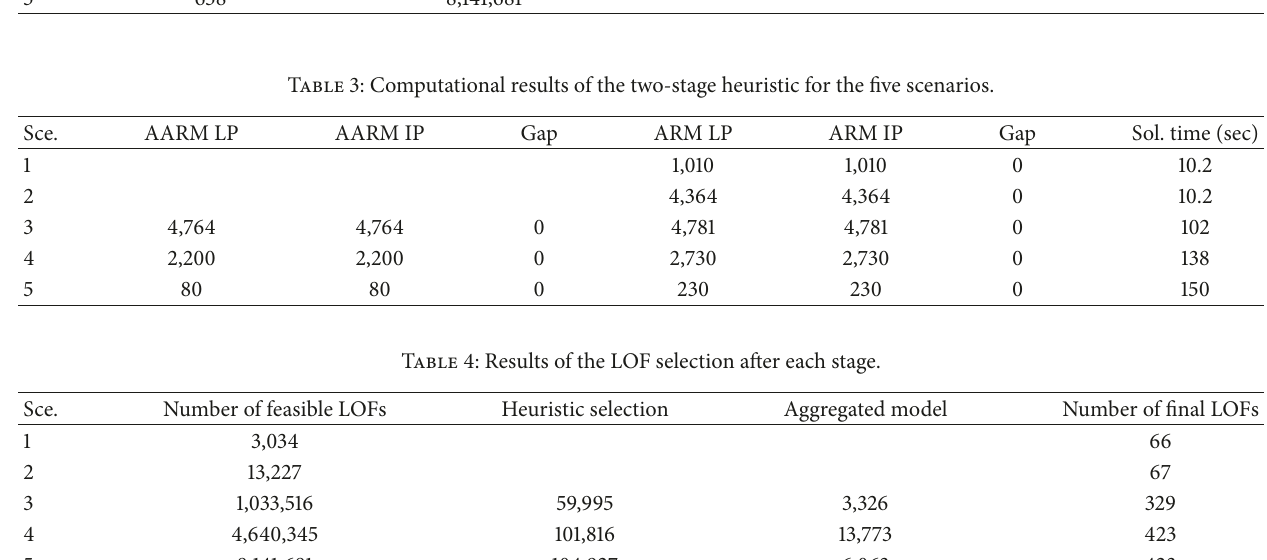
Table 5: Recovery solutions of airlines and the two-stage heuristic.